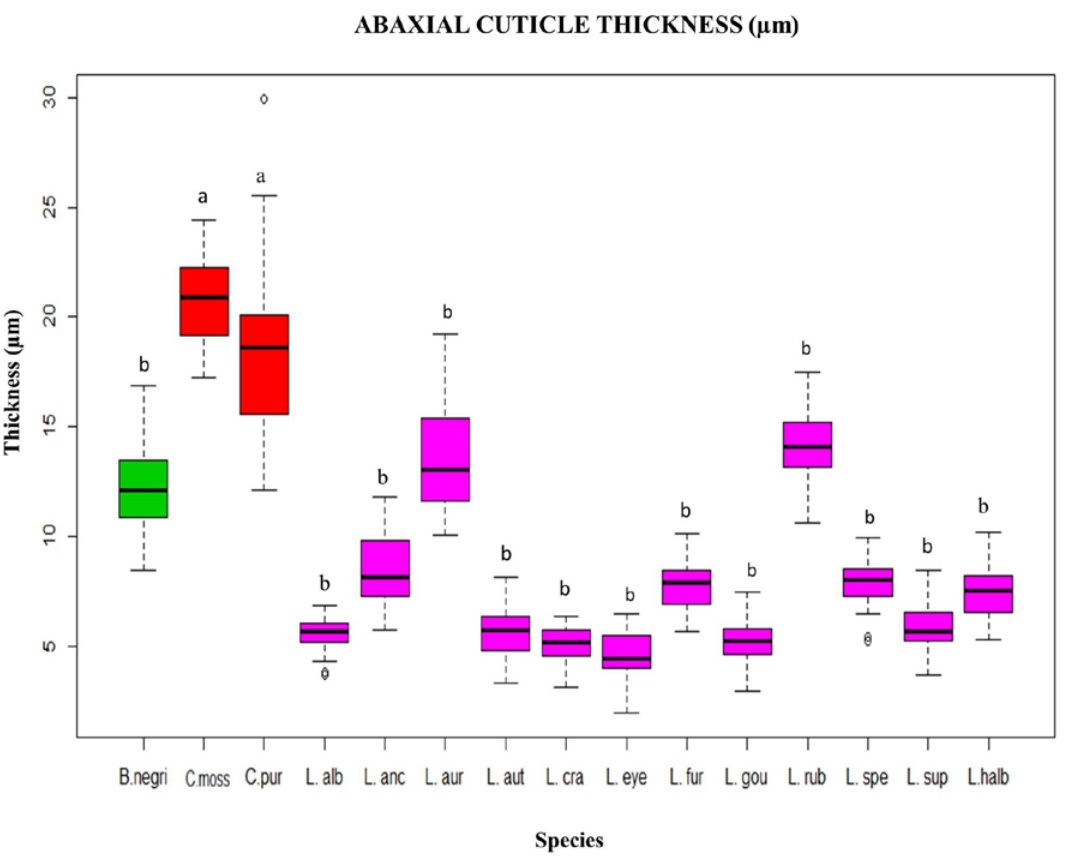
Figure 6. Box plot of the abaxial cuticle thickness evaluated by species. Each color identifies the genera: Broughtonia (green), Cattleya (red) and Laelia (pink). Each letter represents a group, according to Dunnett’s post hoc analysis. a = 0: ≥ 18 μ m. b = 1: ≤ 18 μ m.